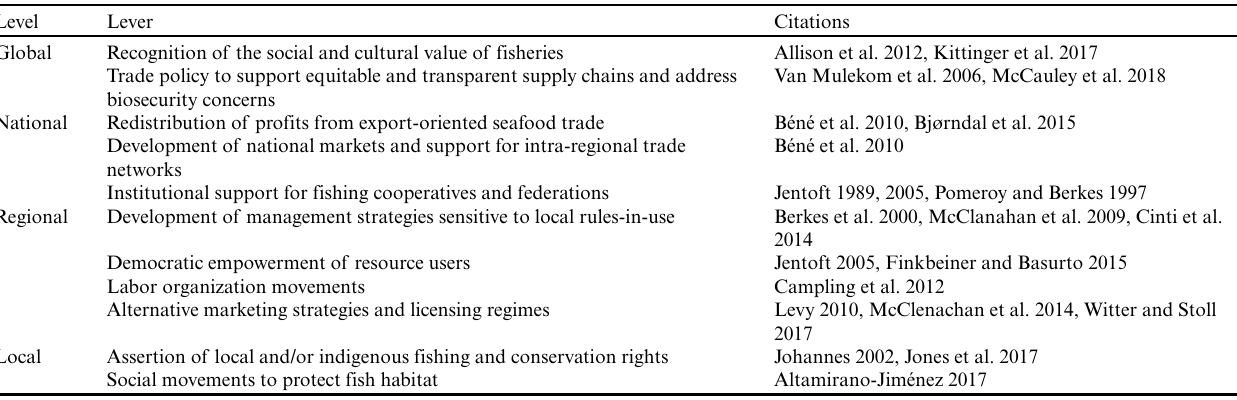
Table 2 . Policy levers (across relevant levels of organization) for improving the structure and function of modern small-scale fishery